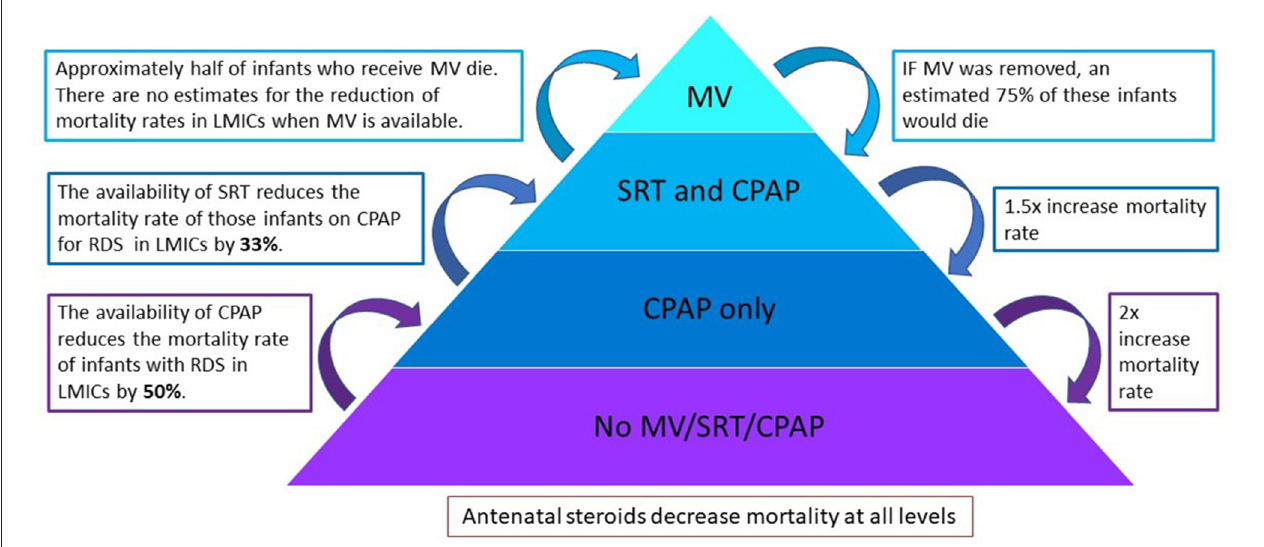
FIGURE 1 | A pyramid composed of levels of interventions to illustrate the modeling methodology. Interventions are removed in a stepwise manner and the number of additional deaths is calculated at each subsequent step. MV, invasive mechanical ventilation; SRT, surfactant replacement therapy; CPAP, continuous positive airway